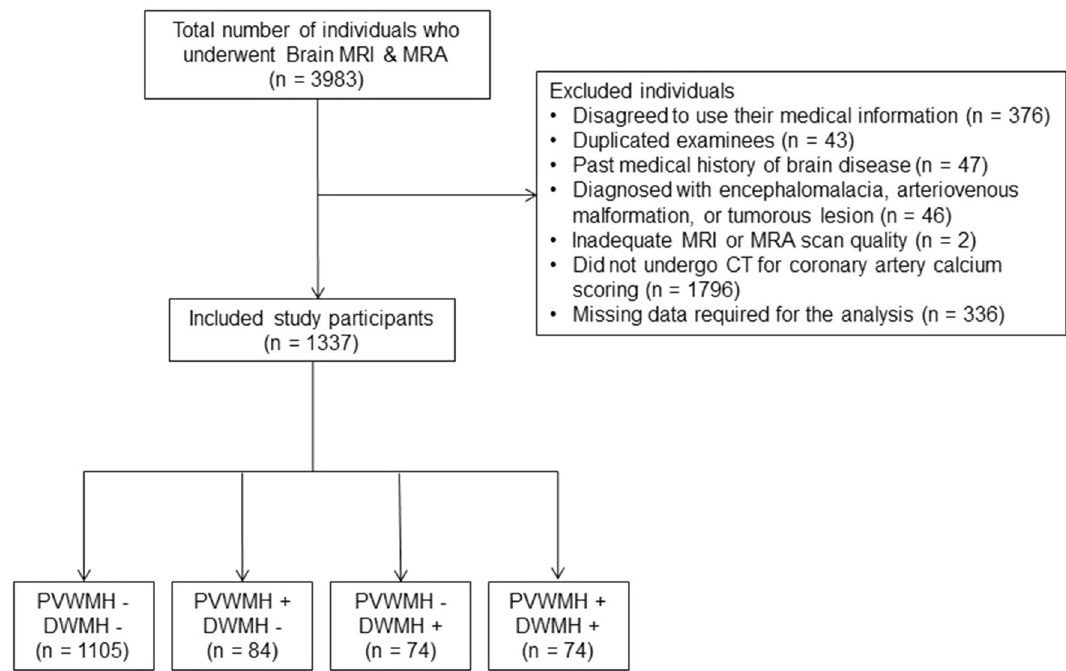
Figure 1. Flow diagram of the included participants. MRI Magnetic resonance imaging, MRA Magnetic resonance angiography, PVWMH Periventricular white matter hyperintensity, DWMH Deep white matter